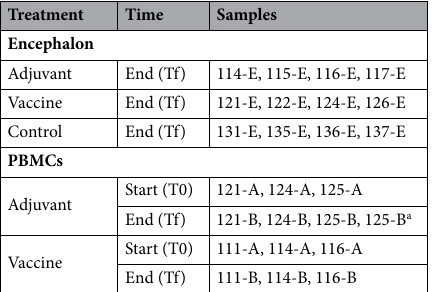
Table 1. Sample summary. a Same RNA sample obtained with a conventional TRIzol extraction